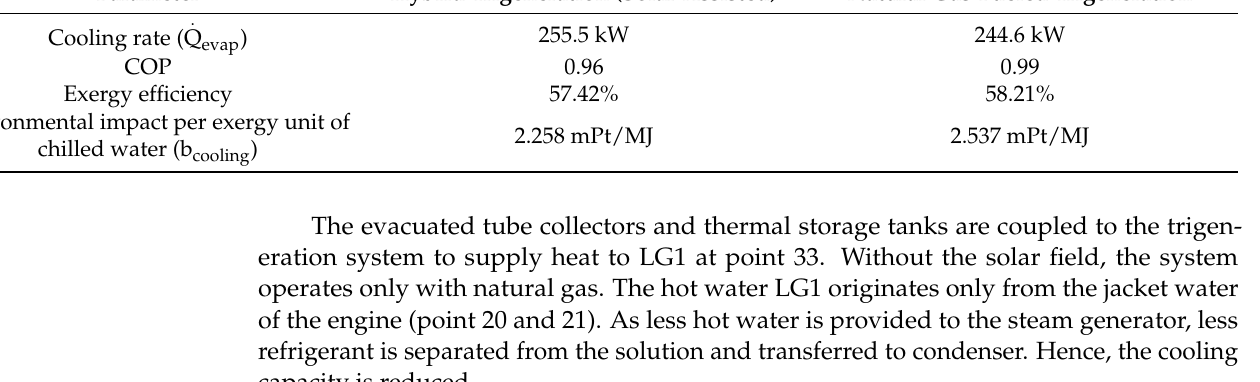
Table 7. Comparison between hybrid and non-renewable trigeneration (without solar field).